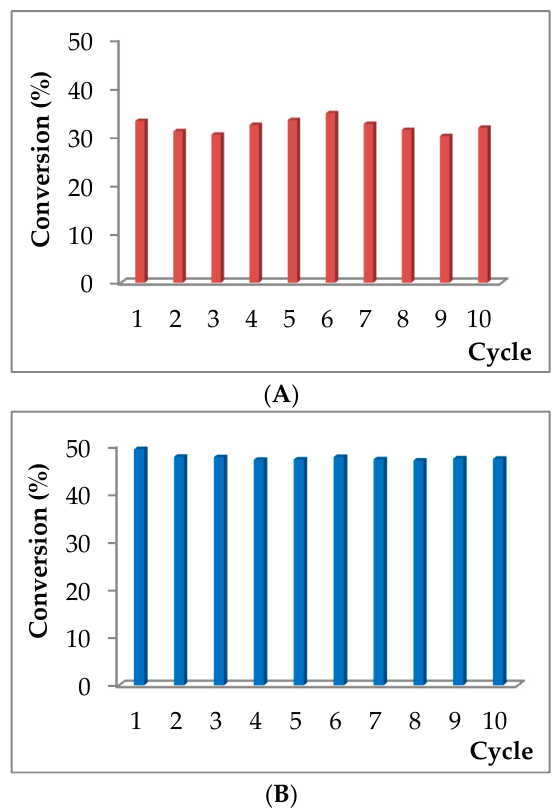
Figure 4. The reusability of the optimal biocatalyst MNP-CS-SC-CaL-B in the EKR of: ( A ). rac- 2e (1 h reaction time) and ( B ). rac- 2i (10 h reaction time).